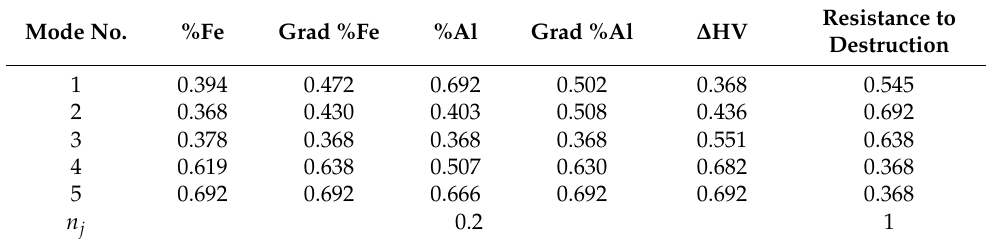
Table 8. The desirability for each quality index (without the influence of n j ). Mode